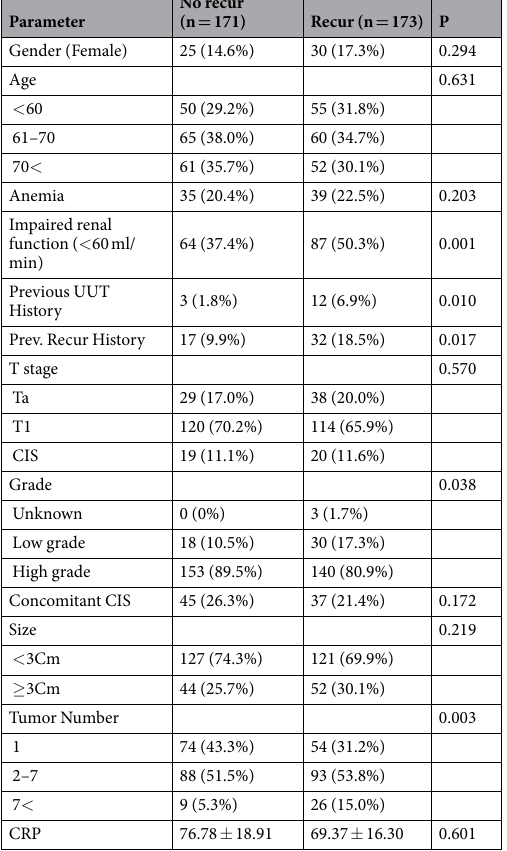
Table 2. Patient and tumor characteristics of recurrence and non-recurrence